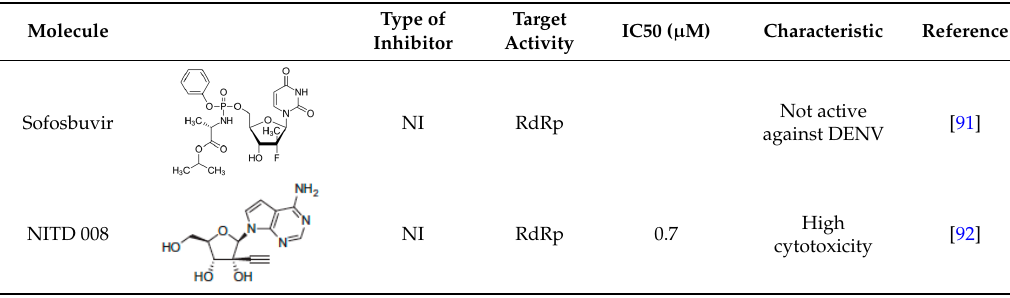
Table 1. Examples of NS5 inhibitors. NIs and NNIs targeting RdRp and MTase activity with half maximal inhibitory concentration (IC50) values and in vitro or in vivo characteristics. NNIs: non ‐ nucleoside inhibitors; NIs: nucleoside